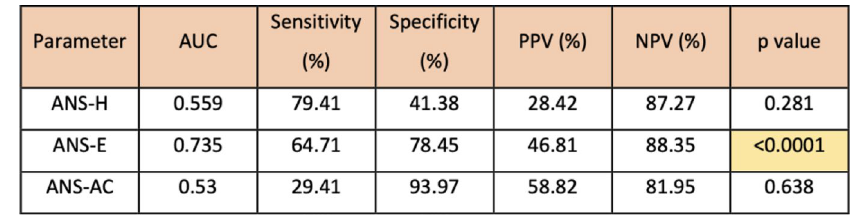
Table 5 Sensitivity, specificity, PPV, NPV, AUC, and p value of the USG